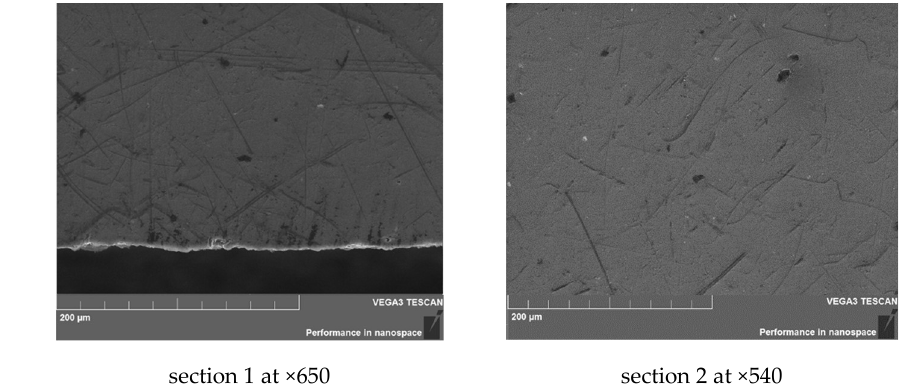
Figure 6. SEM images of the sample Be-1 surface (360 ◦ C, 10 cycles): ( a ) Be-1; ( b ) section 1 at × 650; and ( c ) section 2 at × 540.